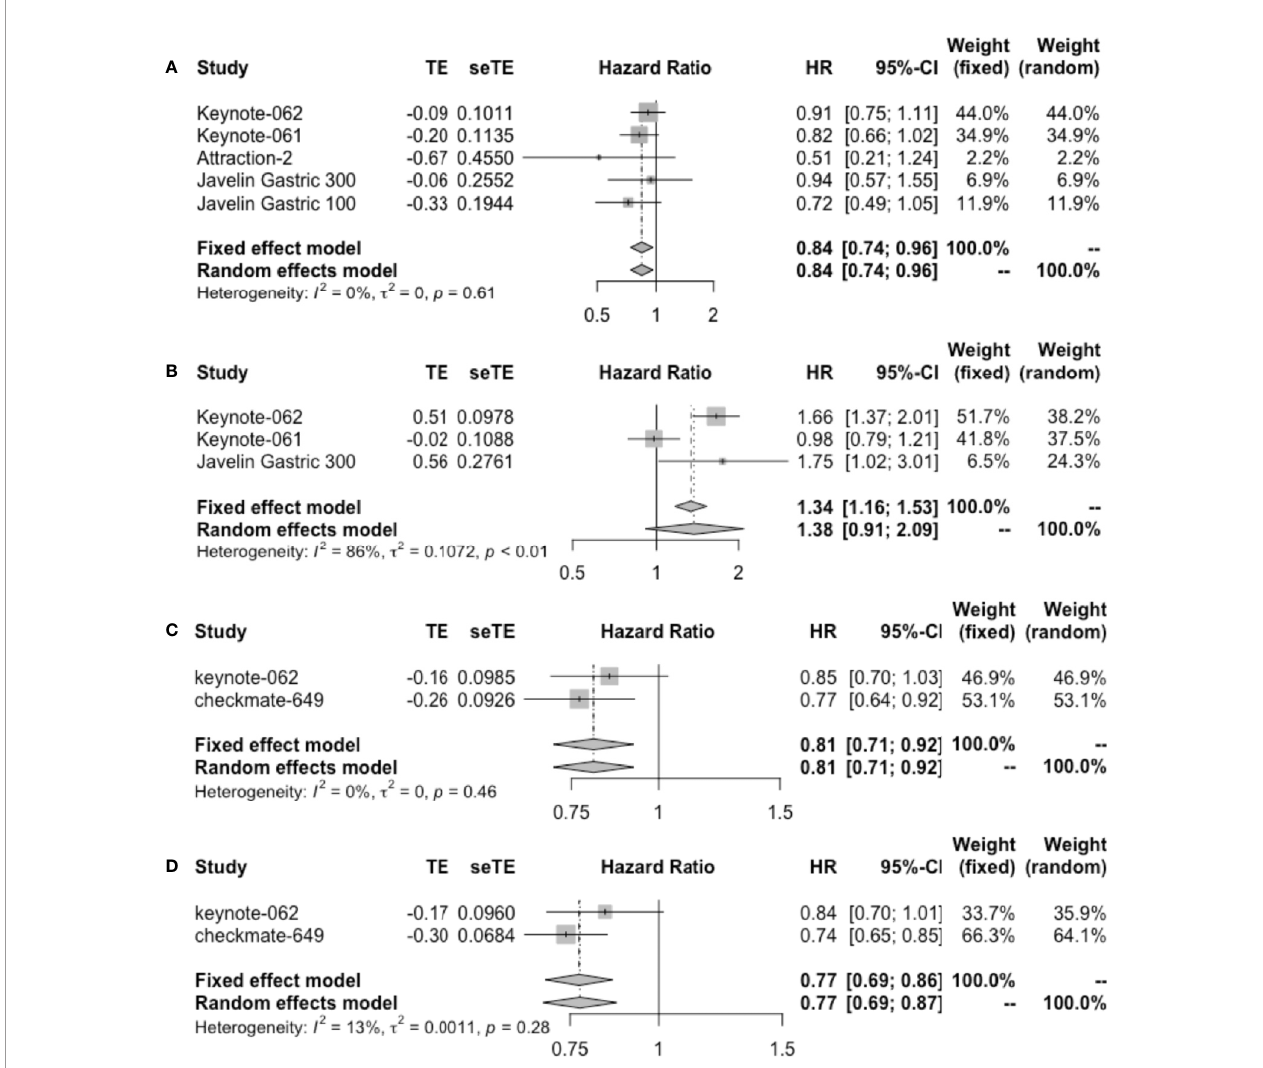
FIGURE 5 | Forest plot of (A) OS and (B) PFS in patients with PD-L1 CPS ≥ 1 administrated with single-agent immunotherapy. (C) OS and (D) PFS in patients with PD-L1 CPS ≥ 1 receiving immunotherapy plus chemotherapy. OS, overall survival; PFS, progression-free survival; CPS, combined positive